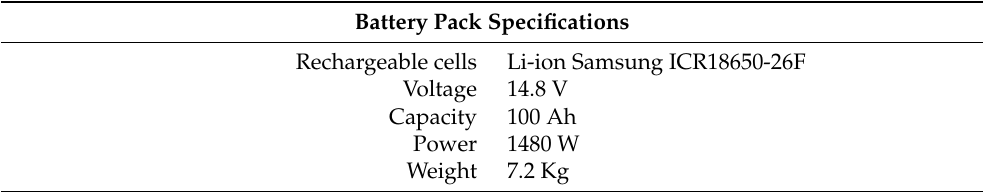
Table 2. Battery pack specifications.